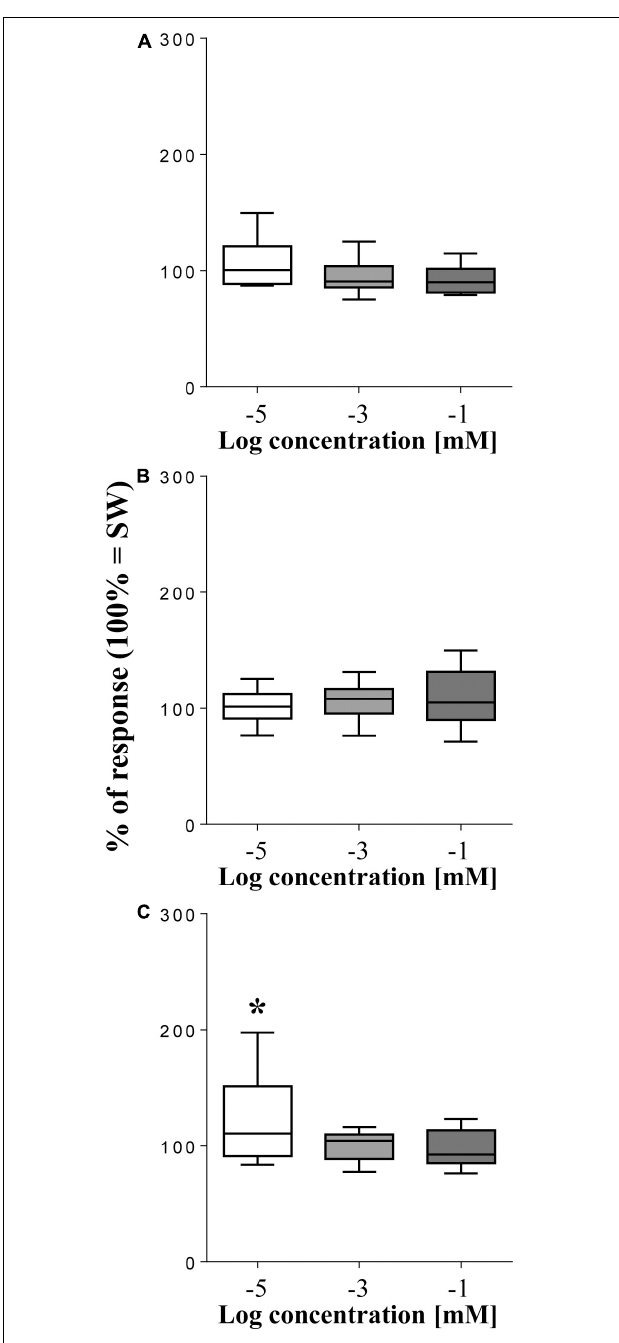
FIGURE 4 | Normalized movement rate of sea urchins, recorded as mean square difference in light intensity (summed peak heights for each preparation during a 2-min stimulation) ± se (vertical bars), following supply of the disaccharides sucrose (A) , trehalose (B) , and cellobiose (C) compared to seawater (SW = 100% of response). The top and bottom of the box and whisker plots show the upper and lower quartiles, respectively. The horizontal line in the middle indicates the median of the corresponding distribution, while the minimum and maximum observed values are indicated by the bars connected to the box. ∗ indicates a significant difference ( p < 0.05, T -test) with respect to SW. Data were obtained from 15 sea urchins for sucrose, 11 for trehalose, and 12 for